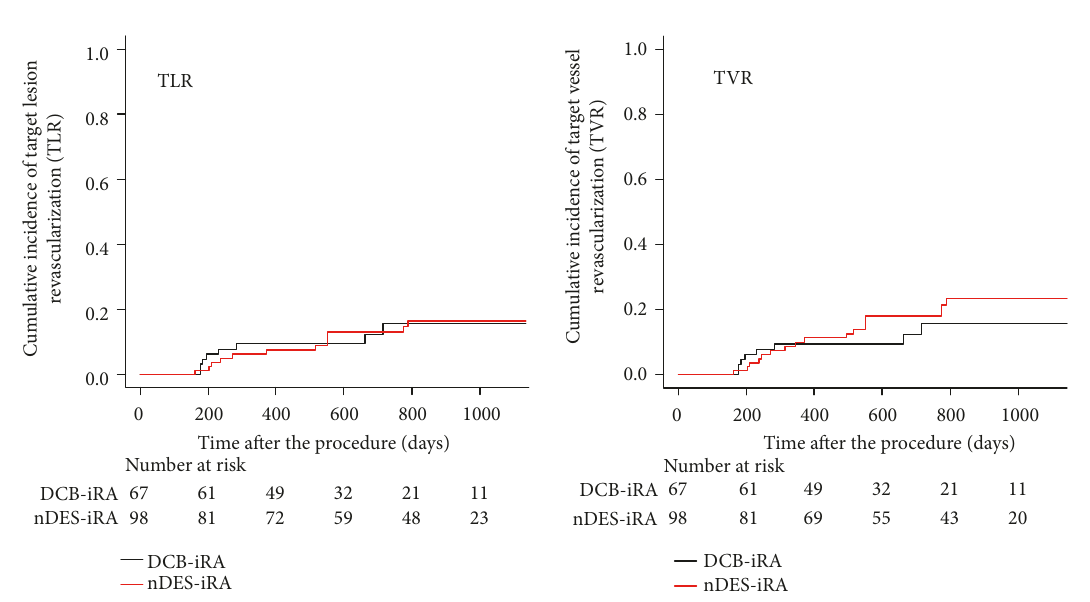
Figure 1: Cumulative Kaplan–Meier estimates of the incidence of target lesion revascularization (TLR) (left panel) and target vessel revascularization (TVR) (right panel), using the crude cohorts of 68 lesions treated with drug-coated balloons (DCB) after intravascular image-guided rotational atherectomy (iRA) (DCB-iRA) and 98 lesions treated with new generation drug-eluting stents (nDES) after iRA